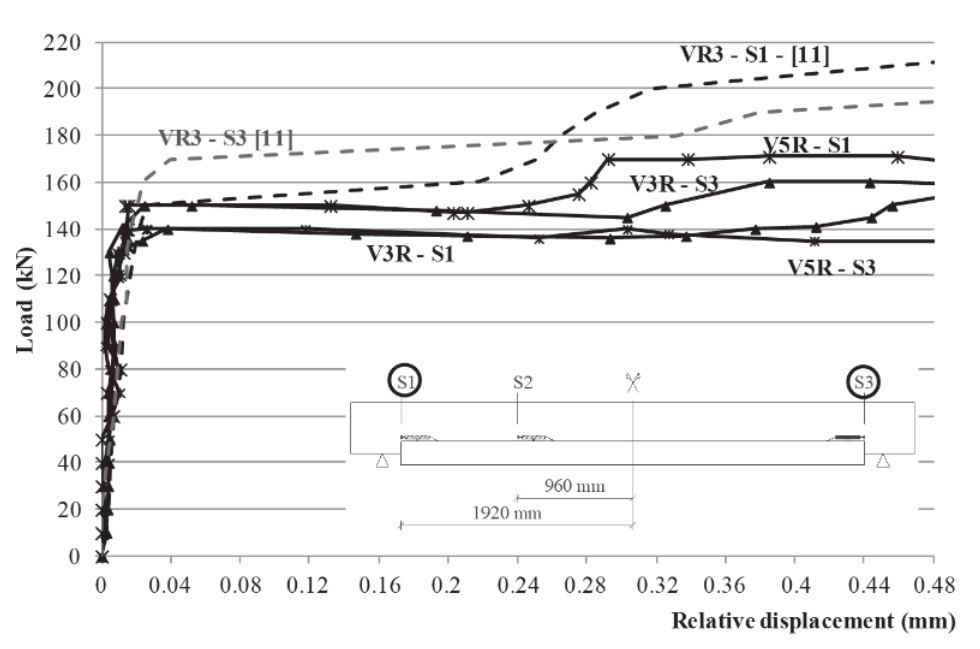
Load - relative displacement at the beam-jacket interface curves of VR3[11], V3R[1] and